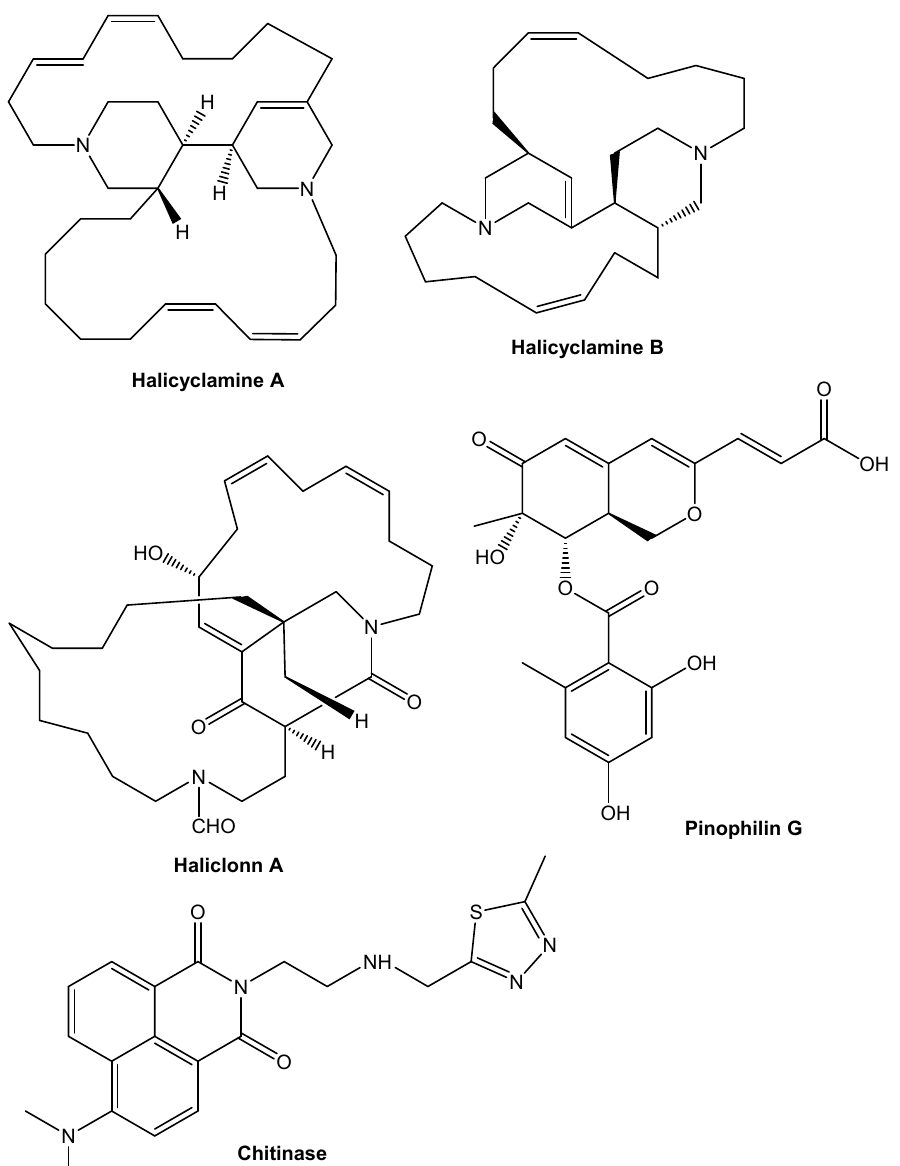
Figure 4. Secondary metabolites presented significant antimicrobial properties from alkaloids, polysaccharides, and fungi.